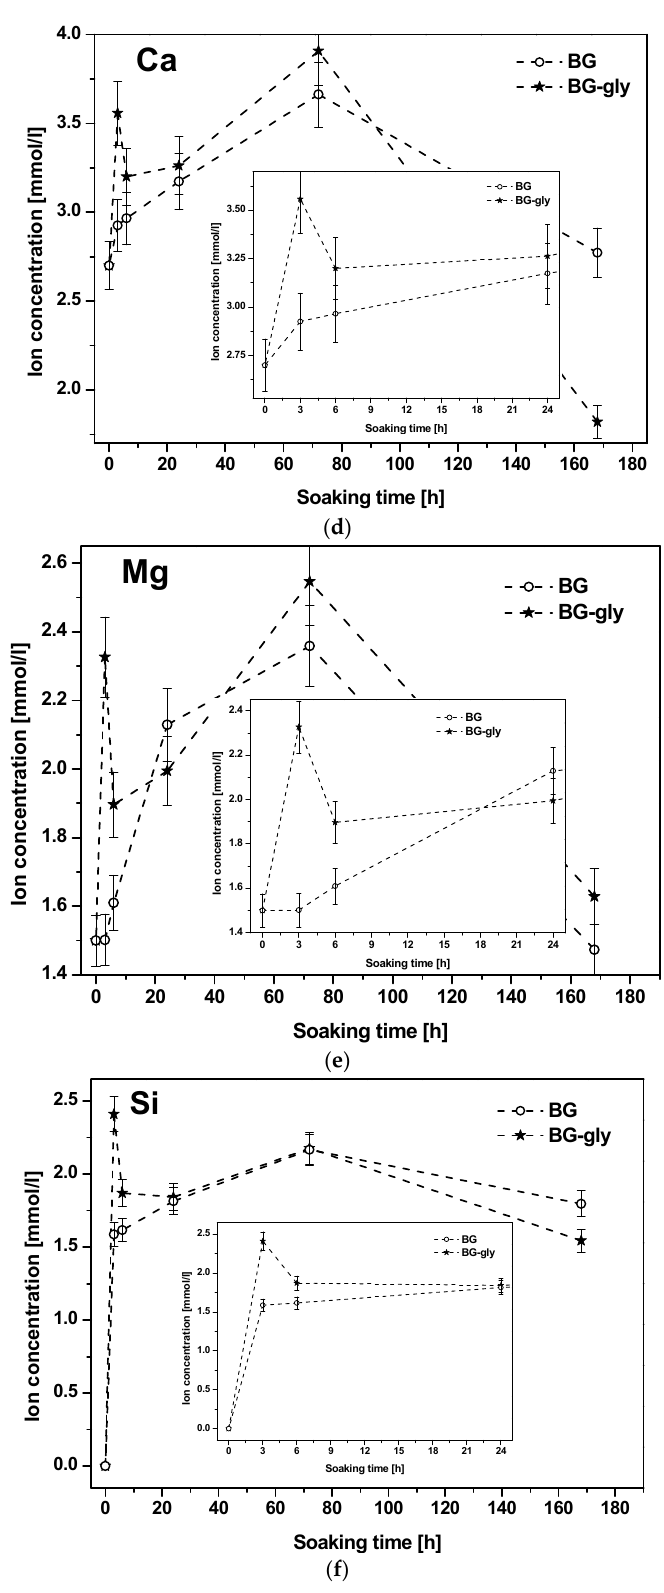
Figure 2. Ionic concentrations in SBF as function of immersion time in SBF: ( a ) BG; ( b ) BG-gly paste (right plots represent magnifications of the grayish areas from the left plots, respectively); ( c – f ) comparison of the evolution of selected ionic concentrations for BG and BG-gly (insets represent magnifications of the soaking time range up to 24